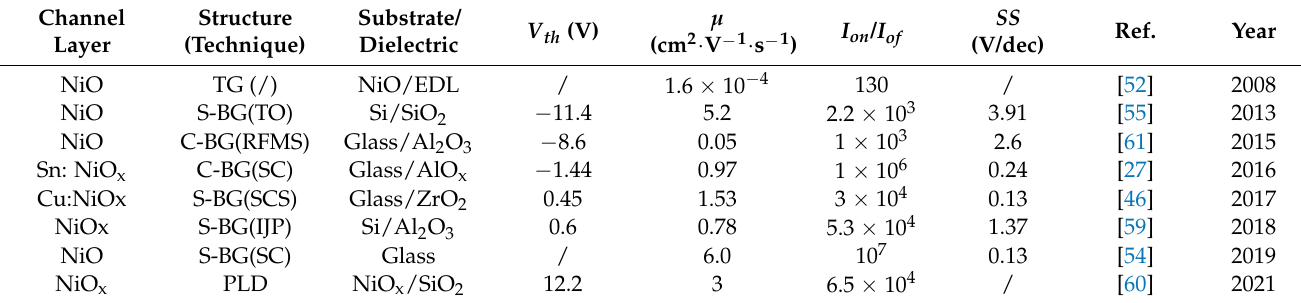
Table 1. Performance analysis of NiO x -based p-Type Thin-Film